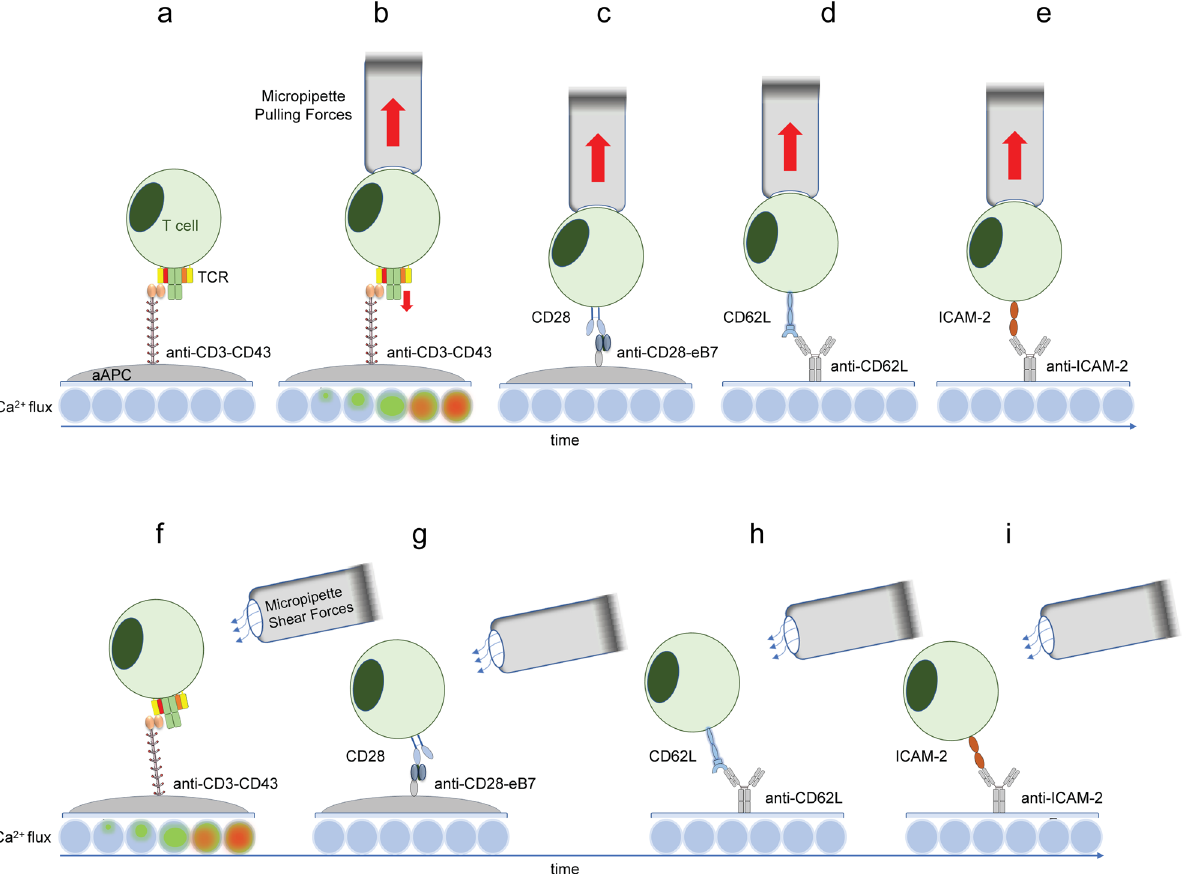
Fig. 2 TCR triggering by mechanical forces. a 3T3 cells were engineered to express surface-bound anti-CD3 scFv elongated with a CD43 tether (anti- CD3-CD43) that allows T cell engagement without inducing TCR triggering (illustrated by a heat map of Ca 2 + fl ux). b Applying force to T cells bound by anti-CD3-CD43 with a micropipette triggered TCR signaling as measured by Ca 2 + fl ux. c – e Similar pulling forces applied to T cells engaged via CD28, CD62L or ICAM-2 did not induce Ca fl ux. f Shear forces applied to T cells engaged via CD3 induced Ca 2 + fl ux. g – i T cells engaged via CD28, CD62L or ICAM-2 did not induce T cell